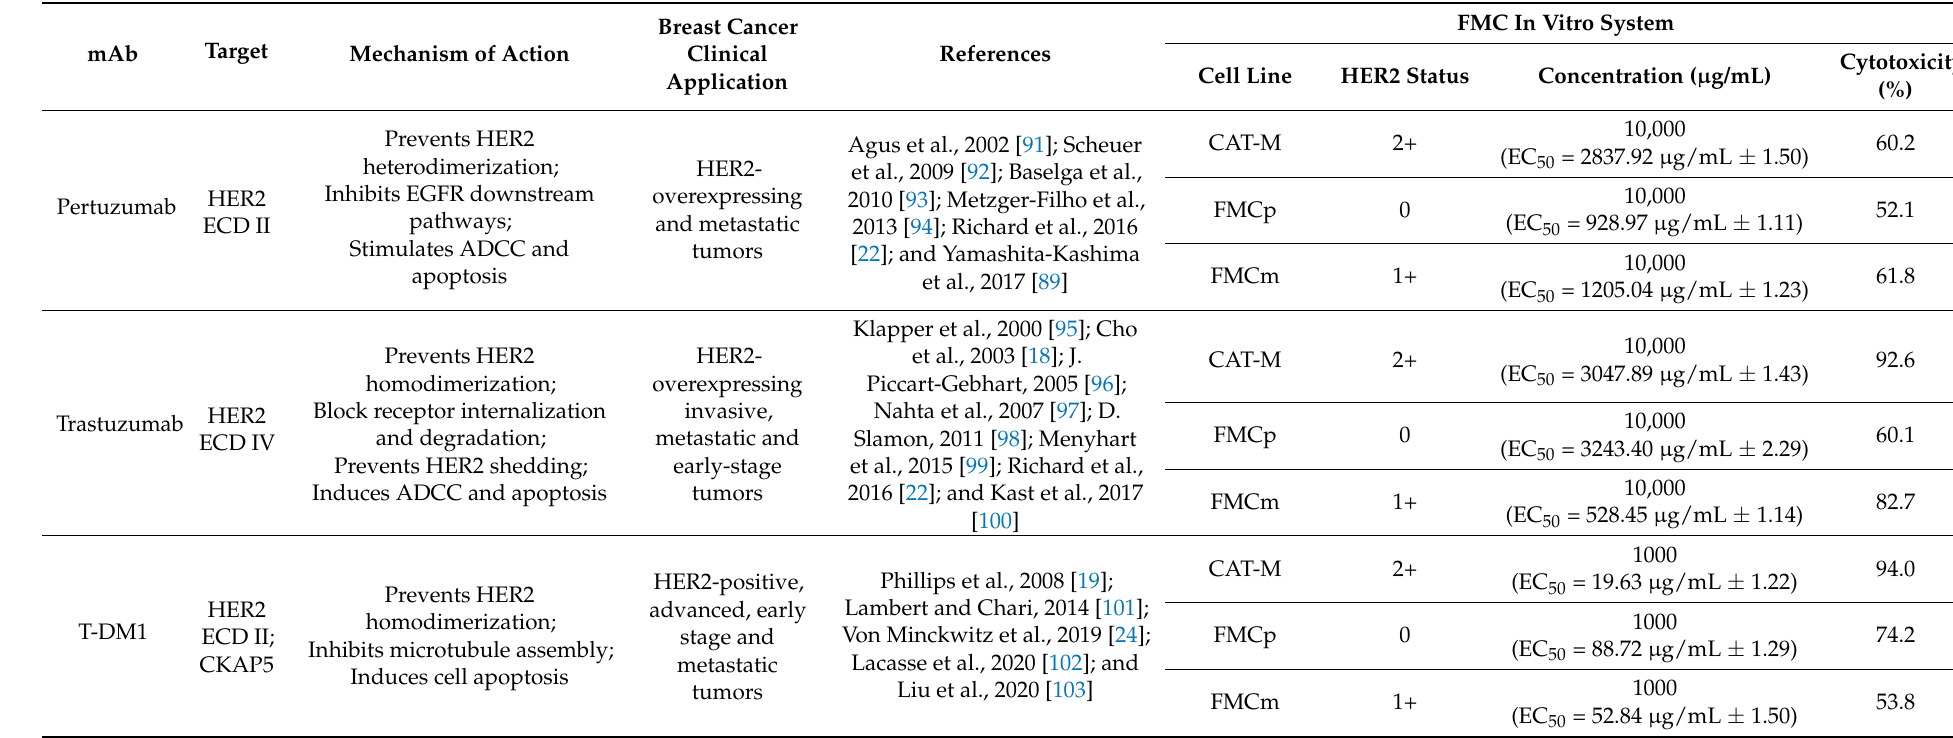
Table 3. Monoclonal antibodies (pertuzumab and trastuzumab) and antibody-drug conjugate (T-DM1) compound induce cell apoptosis, with promising antiproliferative effects in FMC in vitro models